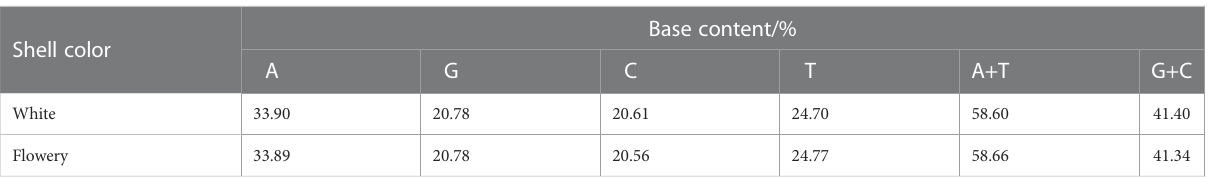
TABLE 3 Base composition of the COI gene in C. tritonis